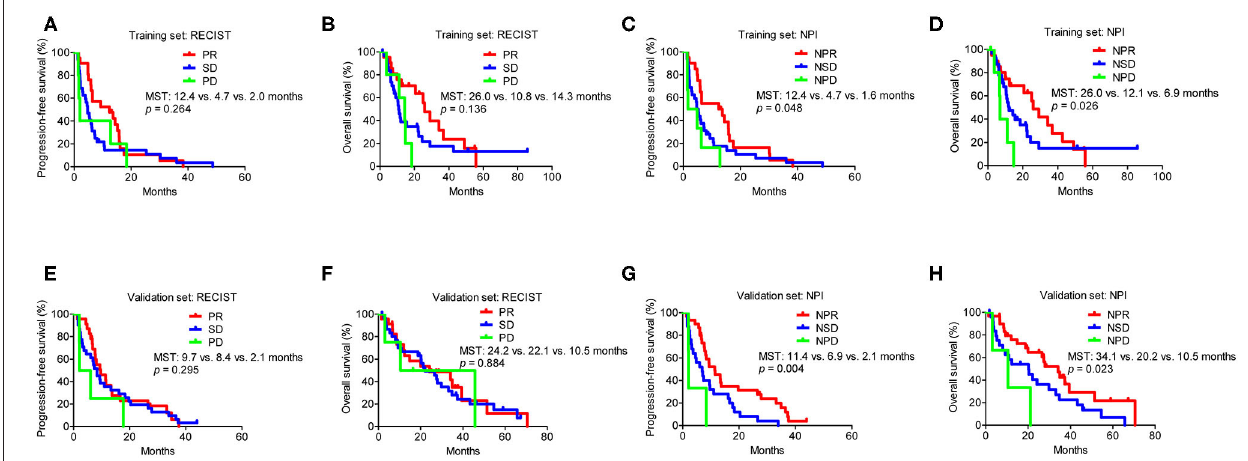
FIGURE 1 | Survival analysis in subgroups according to RECIST and the NPI in the training and validation set. (A) Progression-free survival analysis in subgroups according to RECIST in the training set. (B) Overall survival analysis in subgroups according to RECIST in the training set. (C) Progression-free survival analysis in subgroups according to NPI in the training set. (D) Overall survival analysis in subgroups according to NPI in the training set. (E) Progression-free survival analysis in subgroups according to RECIST in the validation set. (F) Overall survival analysis in subgroups according to RECIST in the validation set. (G) Progression-free survival analysis in subgroups according to NPI in the validation set. (H) Overall survival analysis in subgroups according to NPI in the validation set. MST, median survival time; NPI, new prognostic index; RECIST, Response Evaluation Criteria in Solid Tumors. Based on RECIST, PR: partial response; SD: stable disease; and PD: progressive disease. Based on the NPI, NPR: partial response; NSD: stable disease; and NPD: progressive disease.